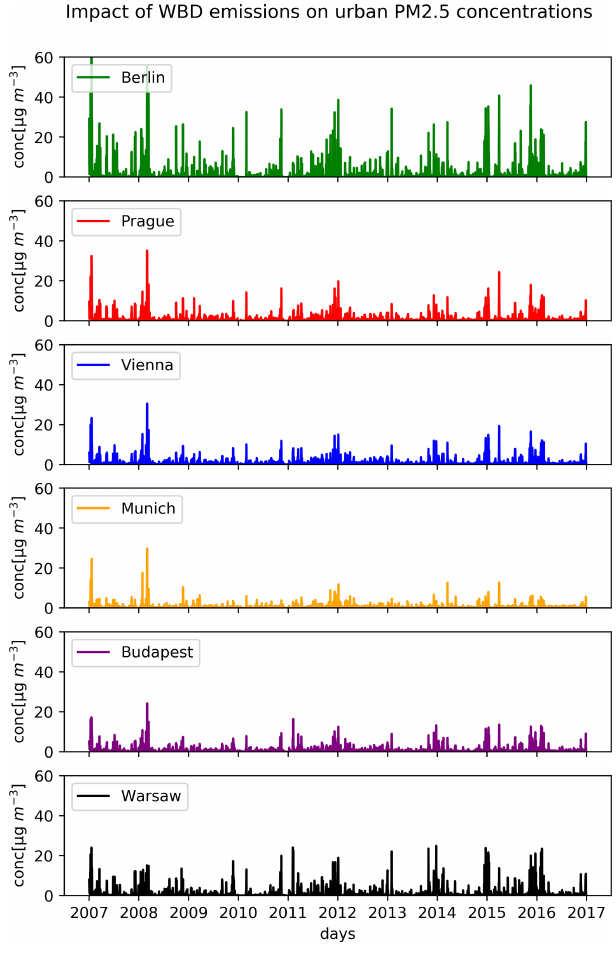
Figure 17. Daily averaged impact of wind-blown dust emissions on PM 2 . 5 concentrations in micrograms per cubic metre for 2007– 2016.